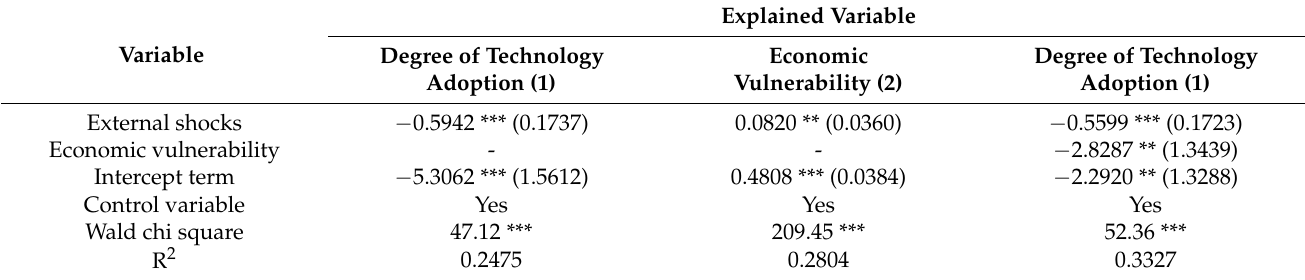
Table A2. Robustness test of mediation effects.